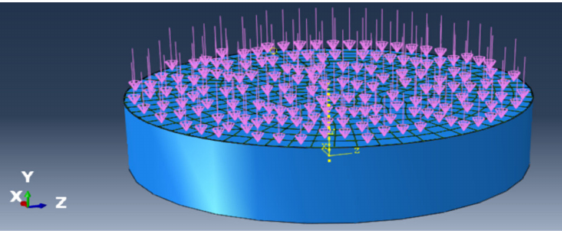
Figure 9. The residual pressure was applied on the top surface of the interface elements before